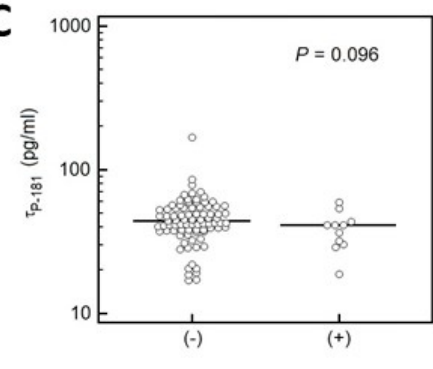
(p.Asp285Asp/p.D285D) synonymous MAPT variant carriers had significantly lower τ p-